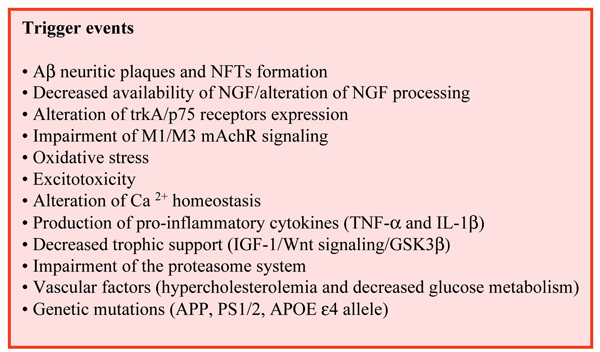
A list of the many genetic and environmental events that contribute to the activation of apoptotic cascades in AD neurodegeneration.